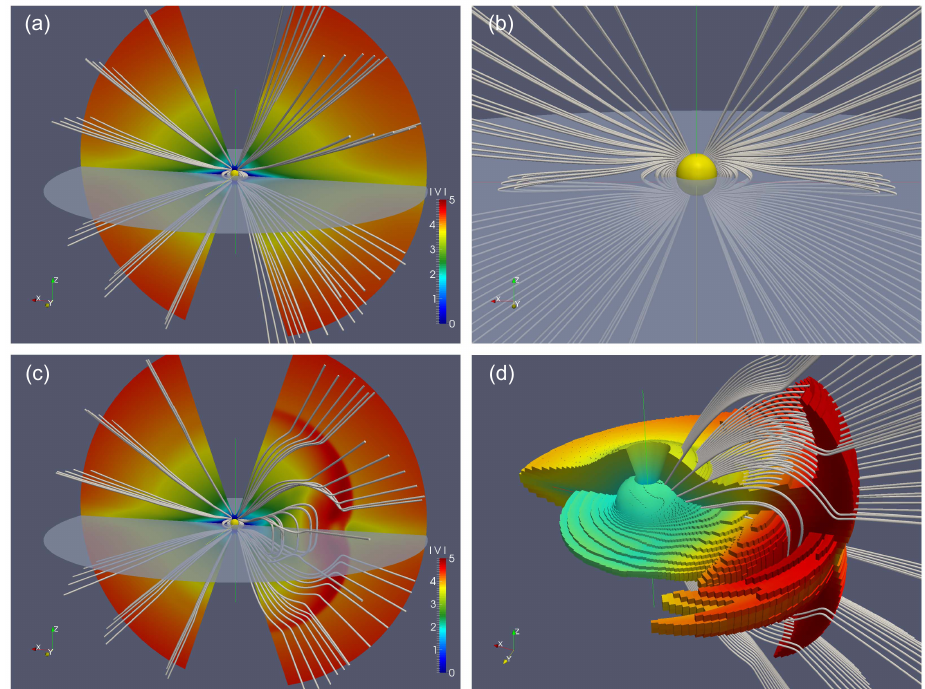
Figure 1. Perspective rendering of our model’s magnetic field and flow configuration. (a) Selected magnetic field lines (white) and absolute velocity in the poloidal plane y = 0 at t = 20, i.e., immediately prior to CME outbreak, showing a quiet Sun situation. The semitransparent disk marks the ecliptic plane. (b) Magnified view of the streamer belt of closed field lines (also at t = 20) emanating from the Sun’s surface (yellow sphere) shown using a different set of lines. The cusps of the outermost field lines extend to about 8 . 5 R (cid:12) . (c) Same situation as above at a later time t = 28, at which the CME has caused a considerable disturbance and restructuring of magnetic topology. (d) Two isocontours of r 2 ρ using the same color coding for V r as above, again amended with selected field lines. Note the CME’s shell-like spatial structure with its distinct ecliptic